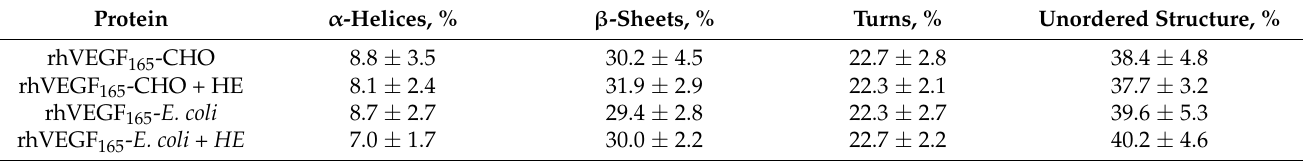
Table 1. The secondary structure fractions estimated from the CD data using CDPro software package [35] for rhVEGF 165 expressed in CHO or E. coli at 25 ◦ C (pH 7.4, 10 mM Na–phosphate, 50